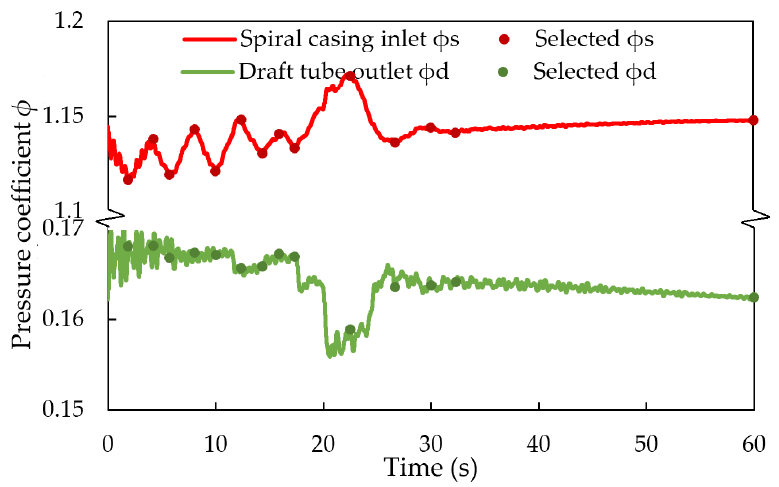
Figure 3. Pressure coefficients at spiral casing inlet and draft tube outlet during the turbine start-up.